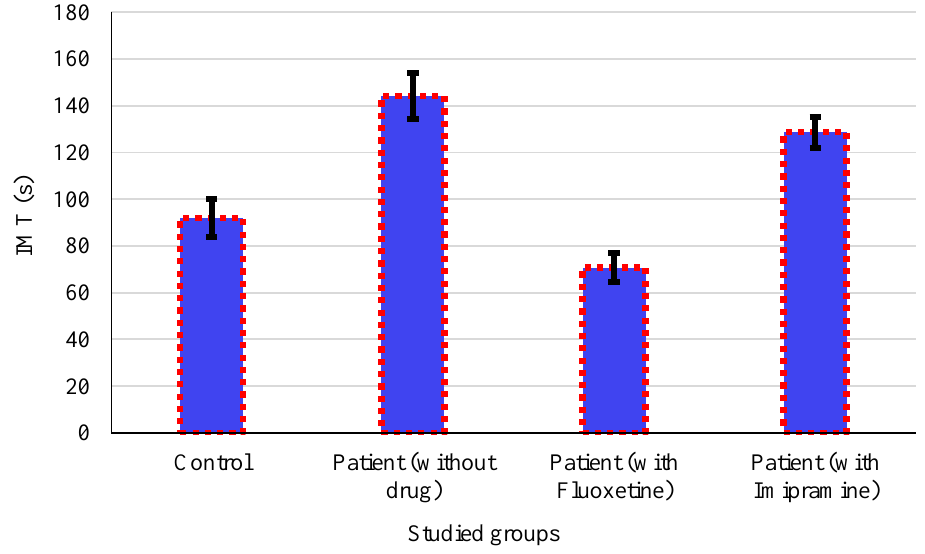
Fig. 4. Comparison of the immobilization stress time between studied